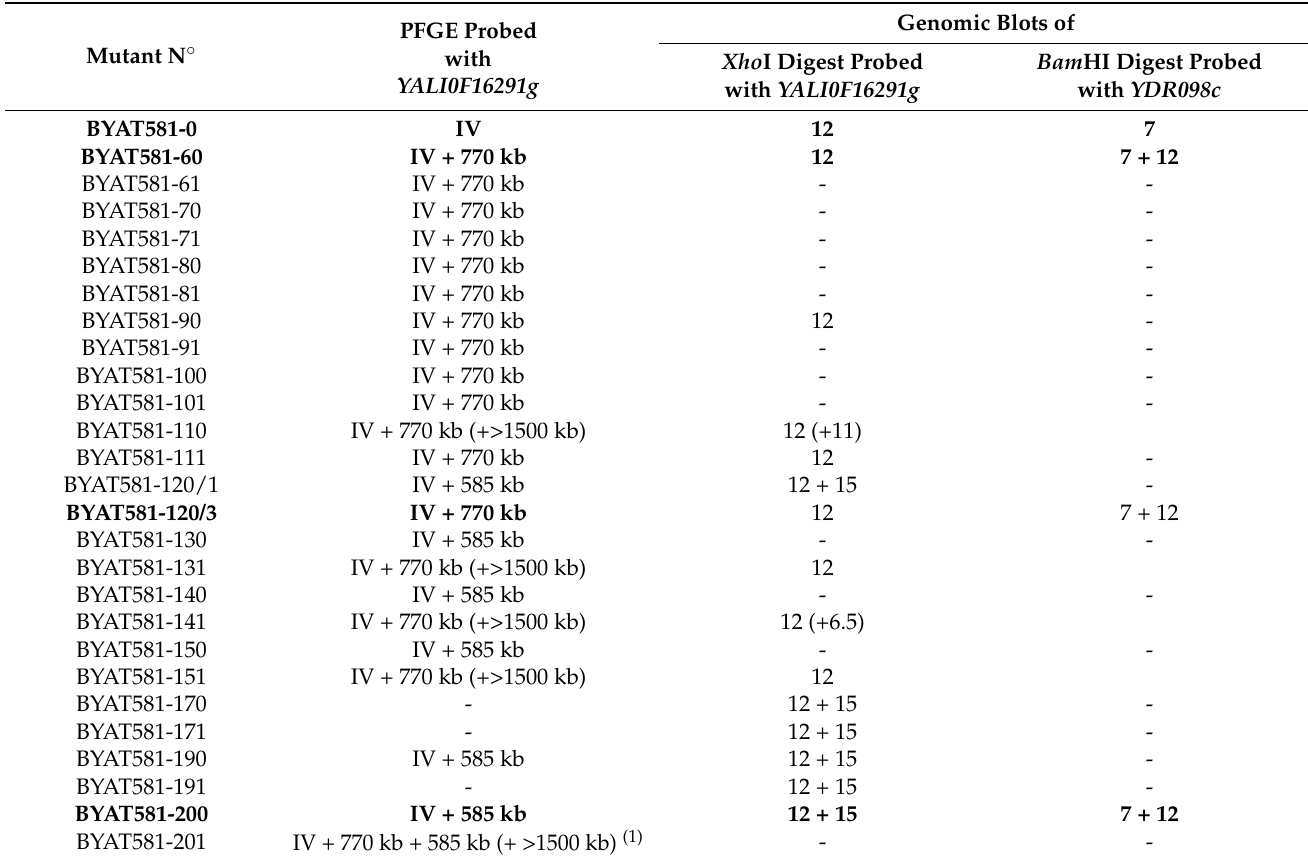
Table 3. Molecular analysis of all evolved mutants of the BYAT581 evolutionary